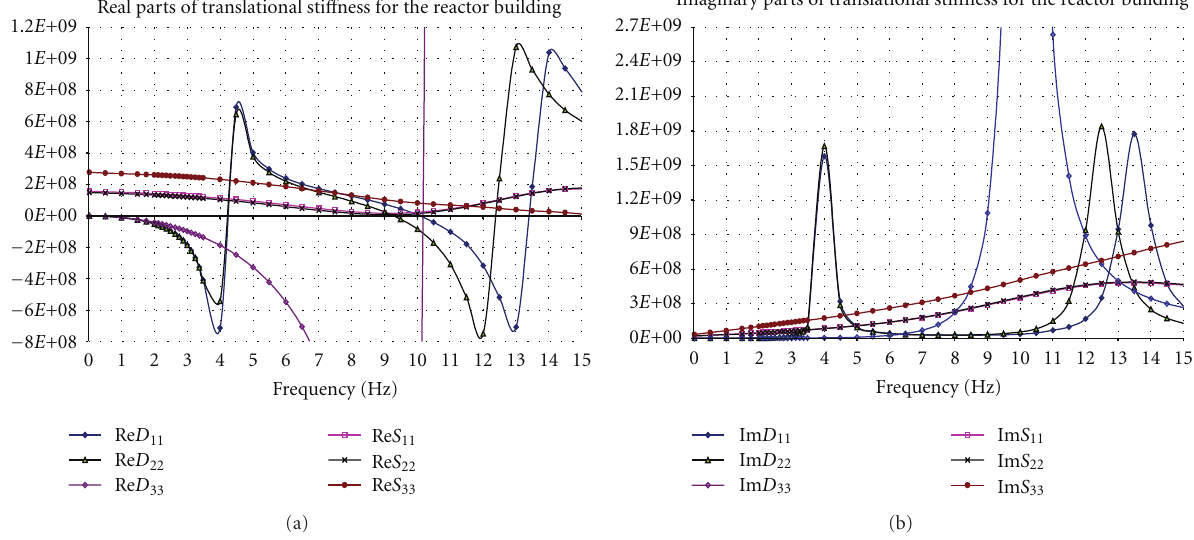
Figure 2: Translational dynamic sti ff ness of the soil and the structure along axes Ox , Oy , Oz for the reactor building basement.